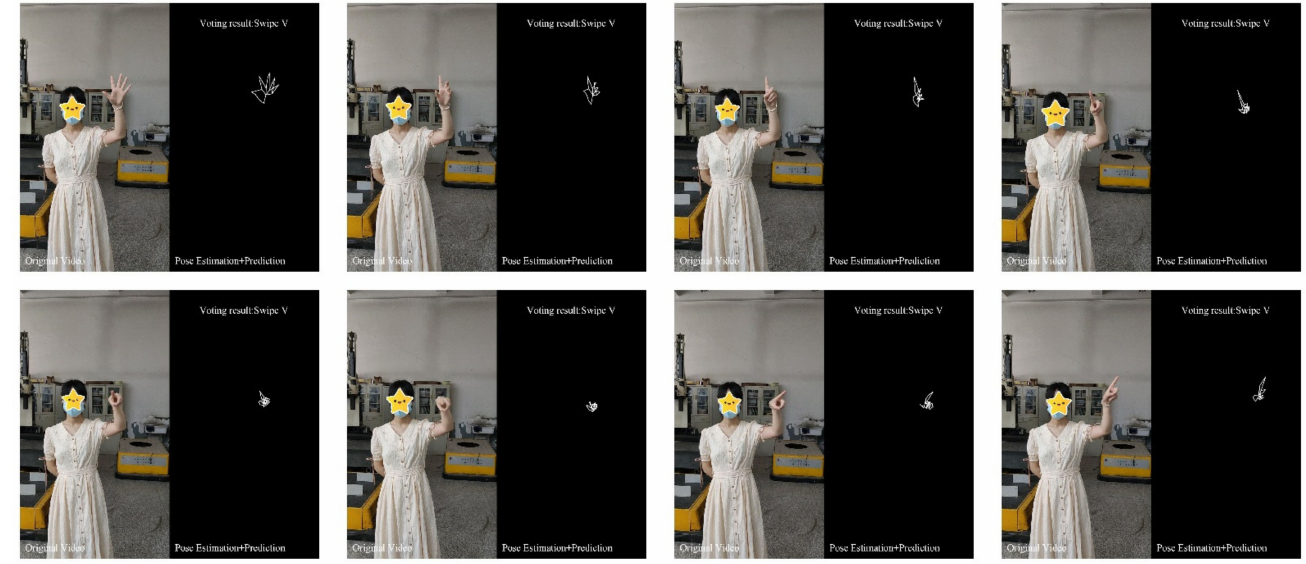
Figure 12. Hand action recognition results (Swipe